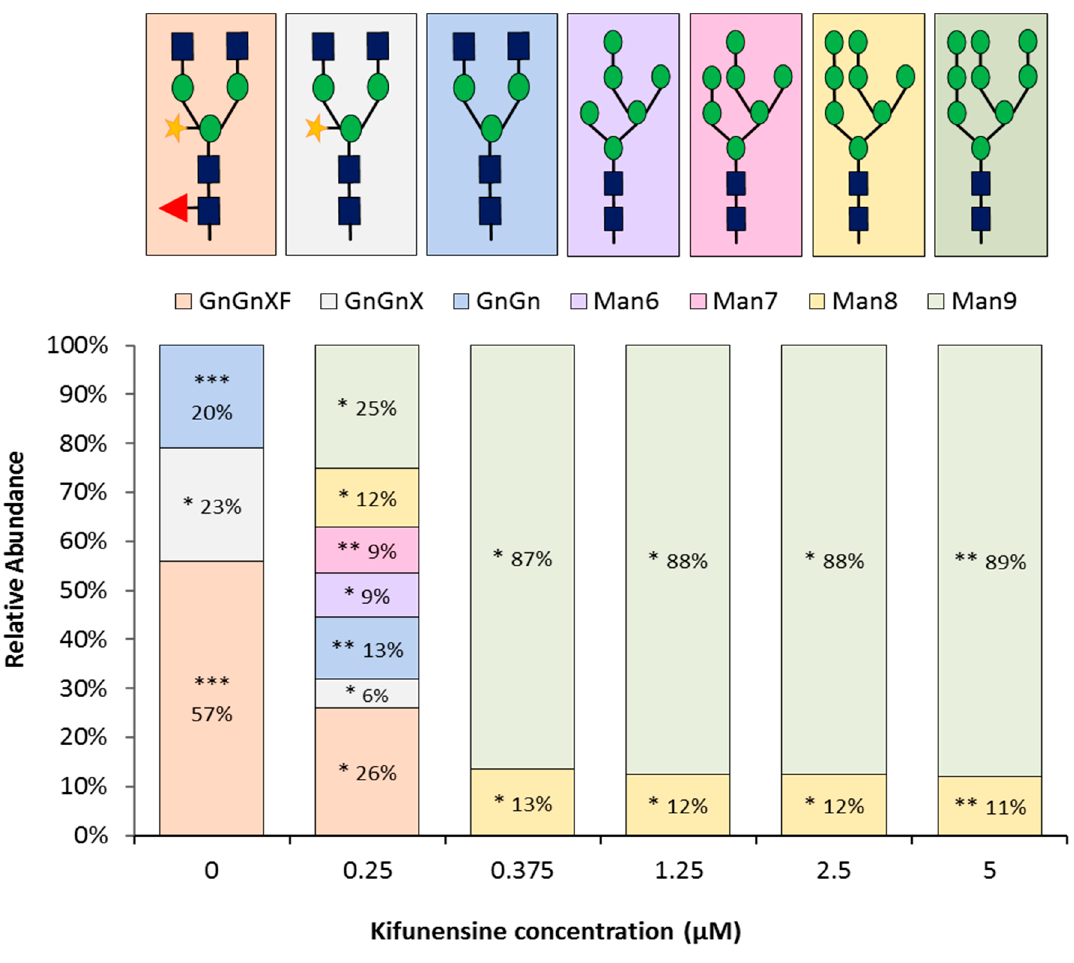
Figure 3. LC-MS glycopeptide profiling of rituximab samples. The ratio between oligomannose glycoforms (Man 8 , Man 9 ) and hybrid glycoforms (GnGn, GnGnXF, and GnGnX) are represented in histograms. Kifunensine concentrations are indicated on the X axis and glycoform percentages are indicated on each sample. Blue squares -N-acetylglucosamine; Green circles -Mannose; Orange Star- Xylose; and Red Triangle-Fucose. Statistical analysis derived from two biological and two technical replicates. Standard deviations (SD) are indicated next to the glycan percentage as follows: * SD value 0 to 1%, ** SD value from 1 to 3%, and *** SD value from 3 to 4%.